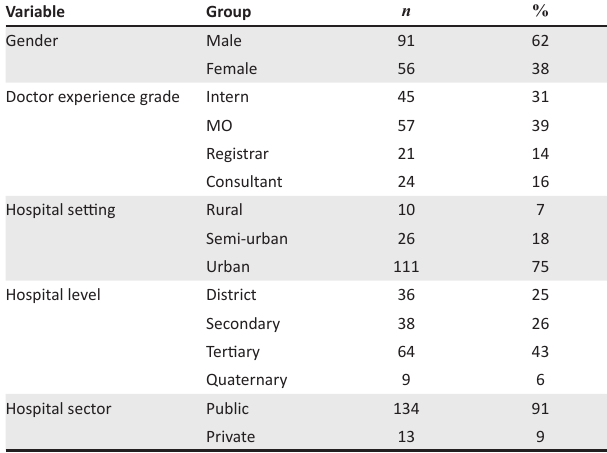
TABLE 1 : Demographic profile of